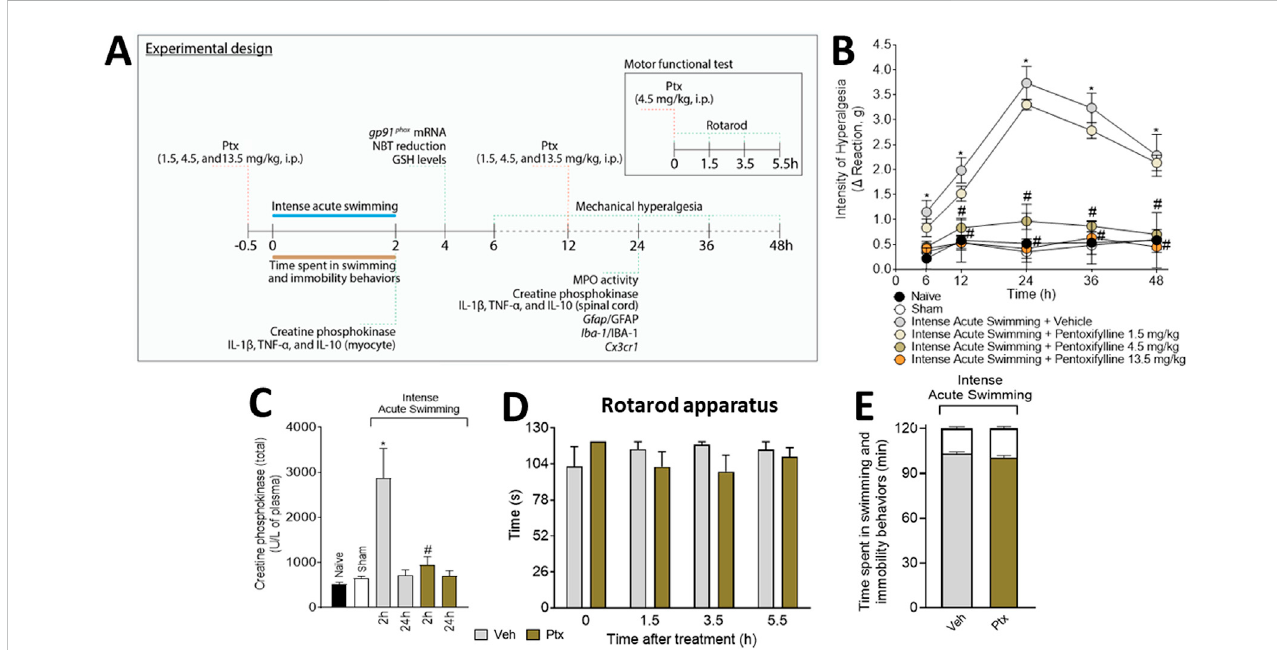
FIGURE 1 Experimental protocol and analgesic effect of pentoxifylline (Ptx). (A) Schematic representation of the experimental protocol used in the study. Ptx inhibitsintenseacuteswimming – induced (B) musclemechanicalhyperalgesiaand (C) increasedplasmaticcreatinephosphokinase(4.5 mg/kgdose;i.p.),and itdoesnotinduce (D) motordysfunctionsorimpairmentsin (E) timespentinswimmingbehavior(thewhitecoloratthetopofthebarsindicatestheimmobility time). Results are presented as intensity of hyperalgesia ( Δ reaction, in grams) and as creatine phosphokinase (total) (U/L of plasma) for CK plasmatic levels, and the results of motor and swimming performance are presented in seconds and minutes, respectively ( n = 6 mice per group per experiment and is representative of two independent experiments). * p < .05 when compared with control groups, # p < .05 when compared with the Veh group (two-way ANOVA followed by Tukey ’ s post hoc